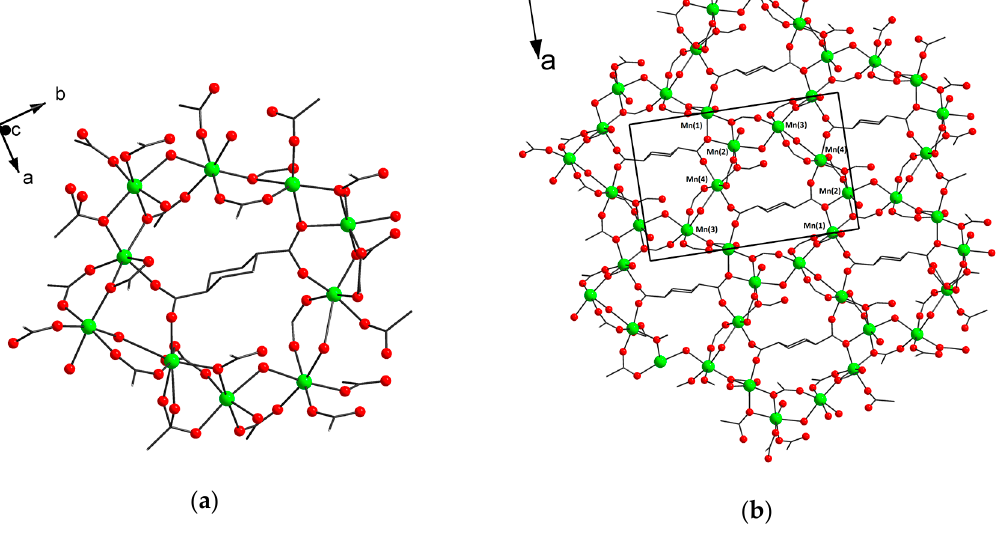
Figure 3. Decanuclear Mn(II) wheel with endo-chdc 2 − ligand in 4 (CCDC 1973665) ( a ). Framework structure of 4 along the c axis ( b ).